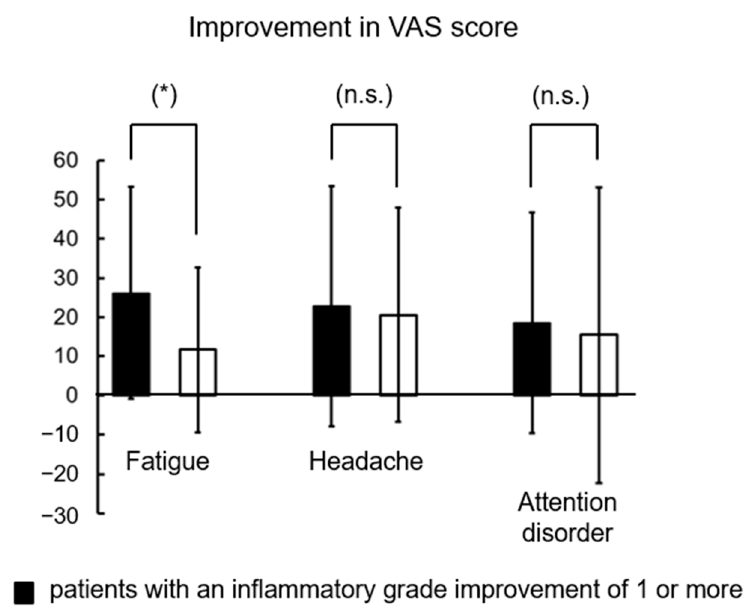
Figure 5. Improvements in VAS scores in 35 patients with an inflammatory grade improvement of 1 or more and 23 patients without an inflammatory grade improvement. Parametric unpaired t -test. * Significantly different at p < 0.05. n.s.: not significantly different.